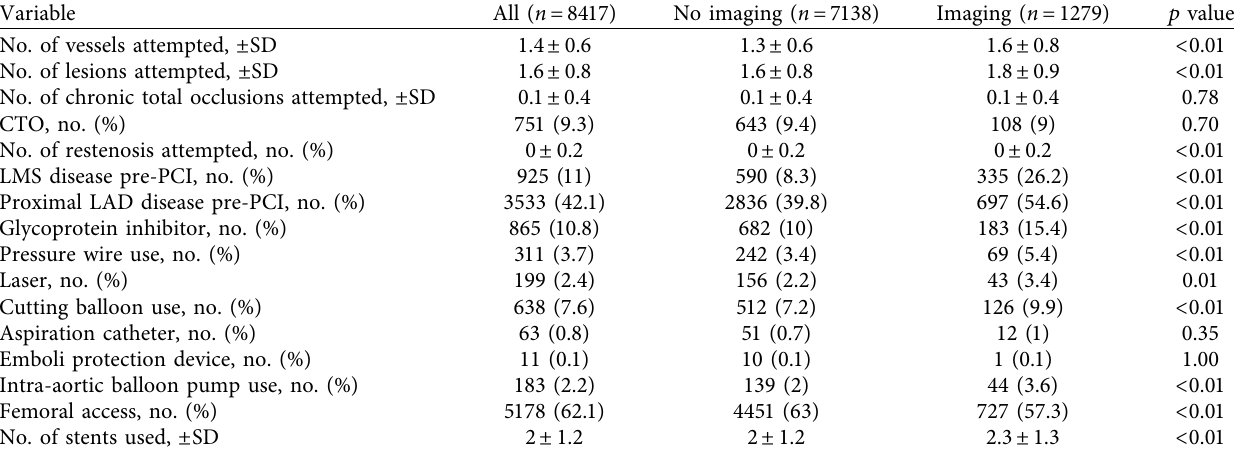
Table 2: Procedural variables by intracoronary imaging use in patients undergoing RA-PCI in England and Wales, 2007 −